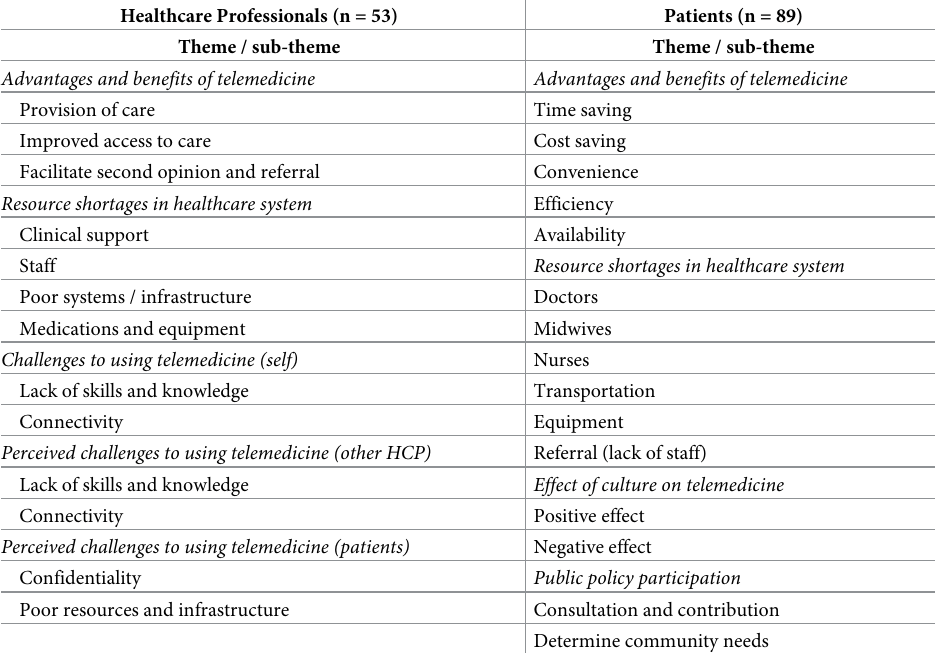
Table 2. Themes and sub-themes from qualitative